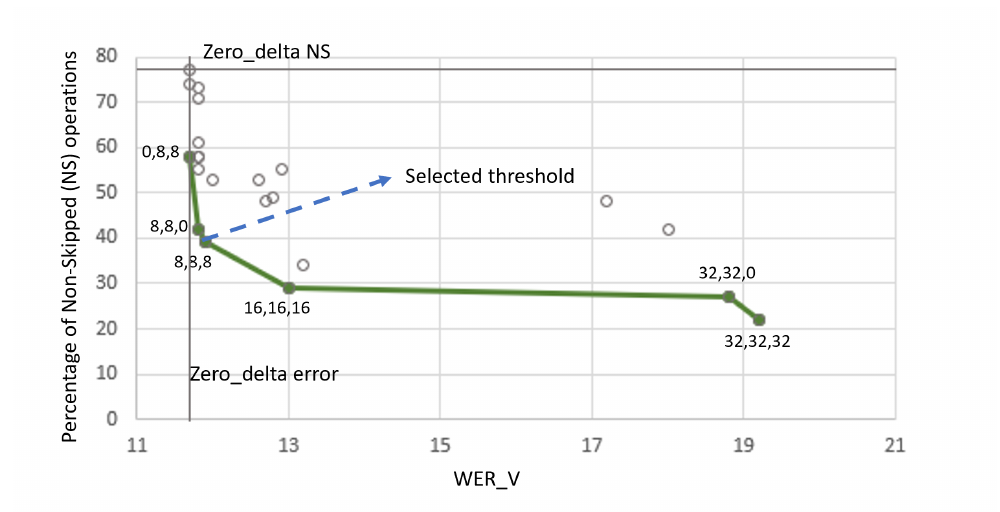
Figure 4. The selection of the delta thresholds for the LSTM-based models with 8-bit integer activation vectors. A threshold of 8 is selected for the input vector, hidden vector, and FC activation